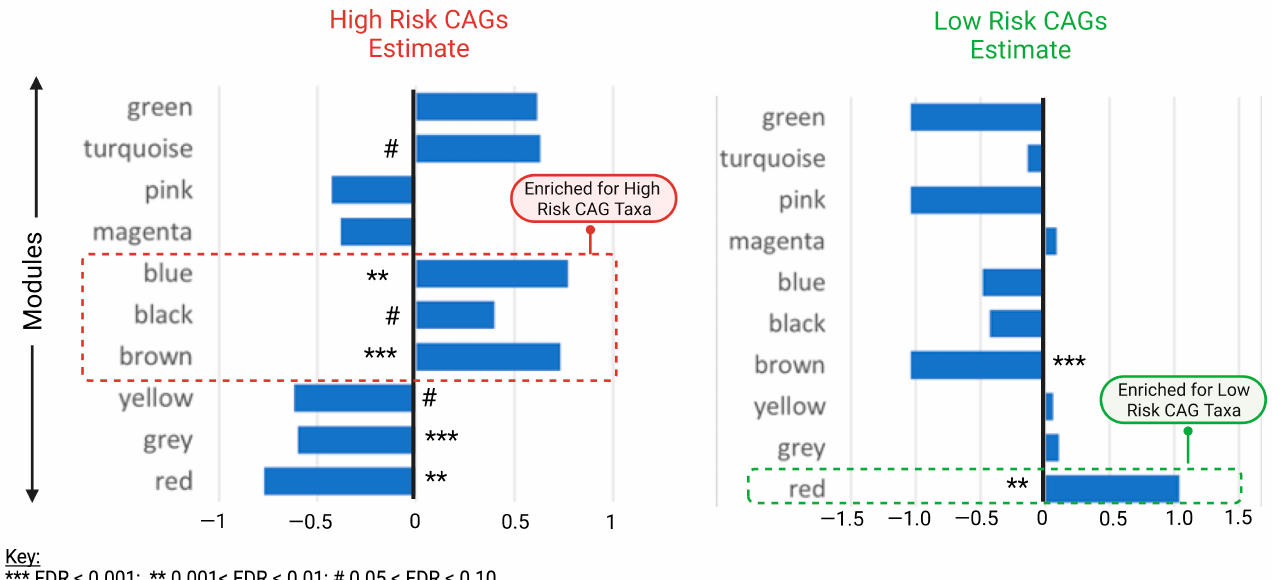
Figure 4. Discrete modules for low- and high-risk Co-Abundant Groups (CAGs). FDR, false discovery rates.